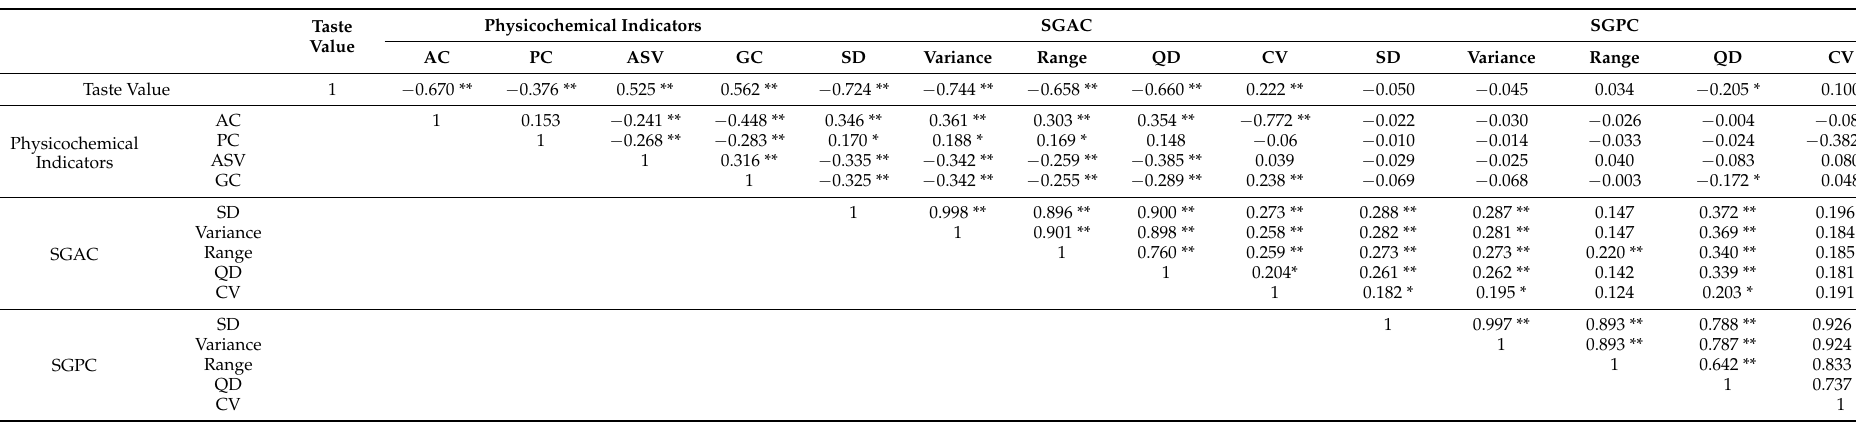
Table 3. Correlation coefficients between physicochemical indicators (amylose content (AC), protein content (PC), alkali-spreading value (ASV), and gel consistency (GC)), variation indicators (SD, variance, range, QD, and CV) in single-grain chemical composition, and taste value of hybrid indica rice. Taste Value